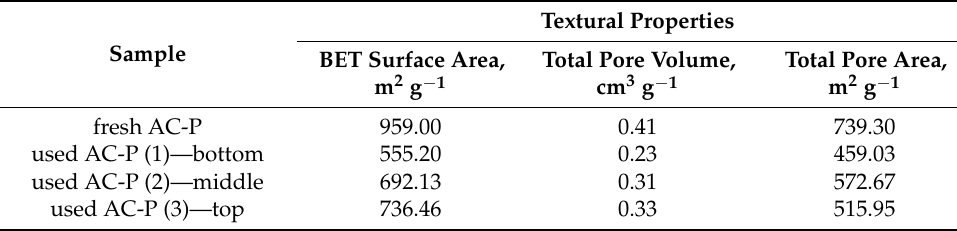
Table 2. Porous properties of the fresh and used impregnated activated carbon